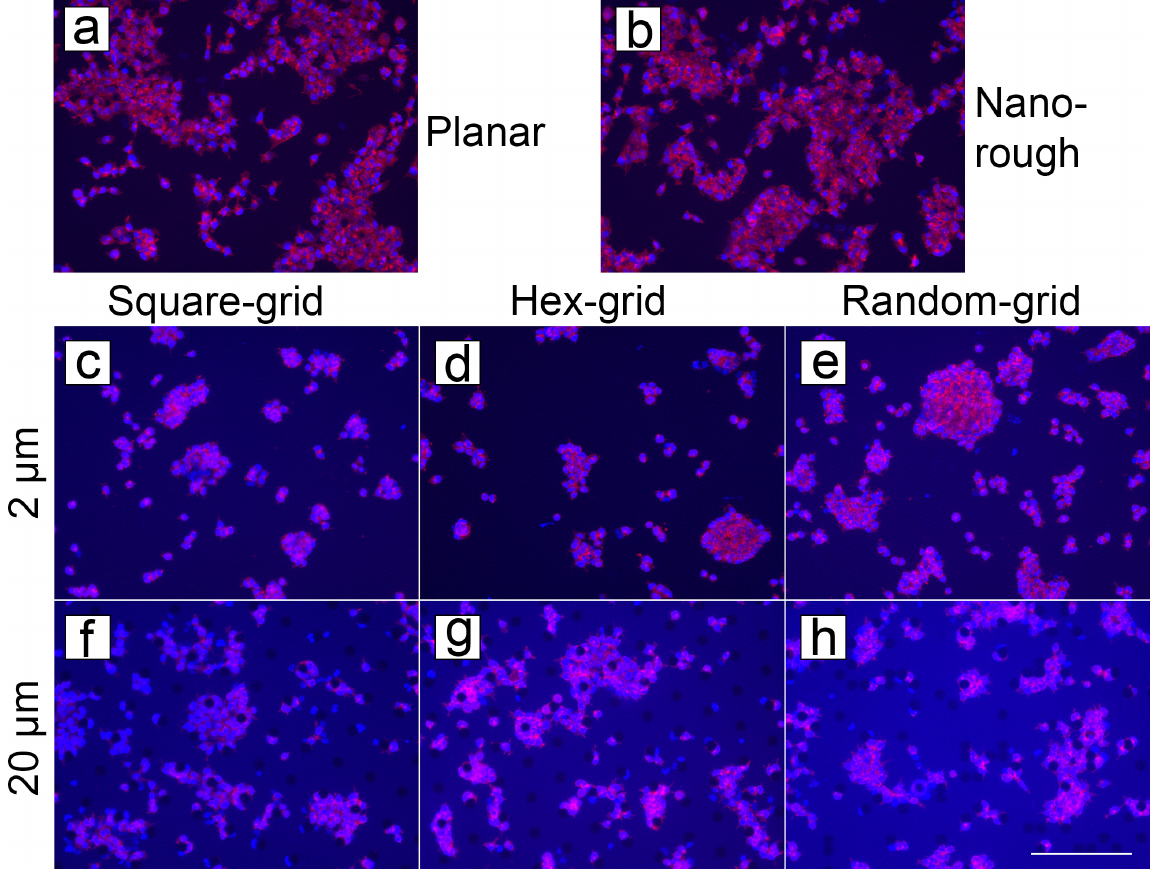
Figure 10. Stained mNSC on ta-C structures. Cells on ( a ) planar ta-C as a reference, ( b ) nanorough silicon surface with ta-C coating, ( c – e ) 2 µ m pillars and ( f – h ) 20 µ m pillars. Scalebar: 200 µ